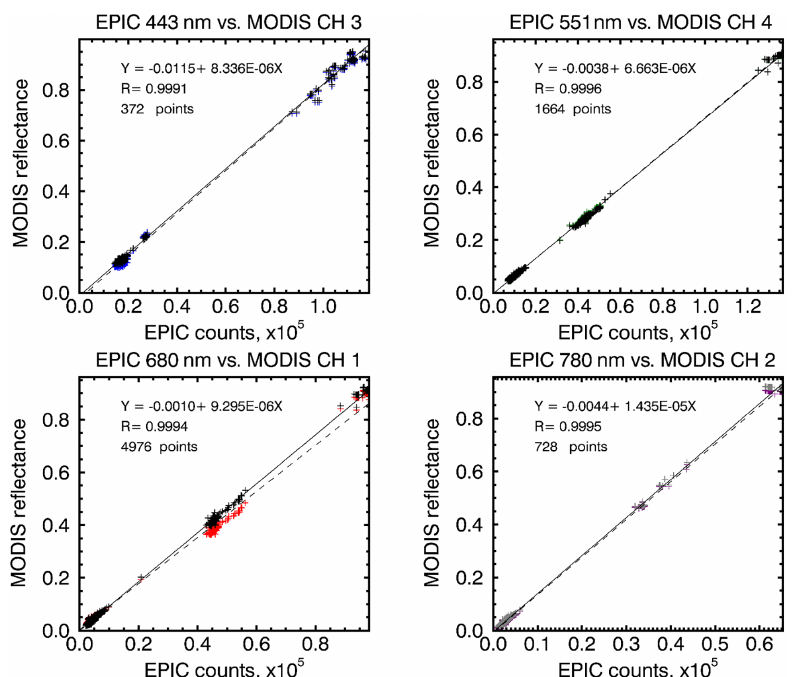
Figure 4. Scatter plots of the MODIS reflectance vs. EPIC Version 2 countss − 1 in four spectral channels for the most homogeneous matching scenes and the corresponding regression lines and equations. The matches between June 2015 and March 2017 are used. Also shown are correlation coefficient R and the number of points used for the regression. The colored marks and dashed lines are for the data without spectral correction, while the black marks and solid lines are for data with spectral correction. Table 2. Ratio/regression gain coefficients differences of the gain coefficients for the four EPIC